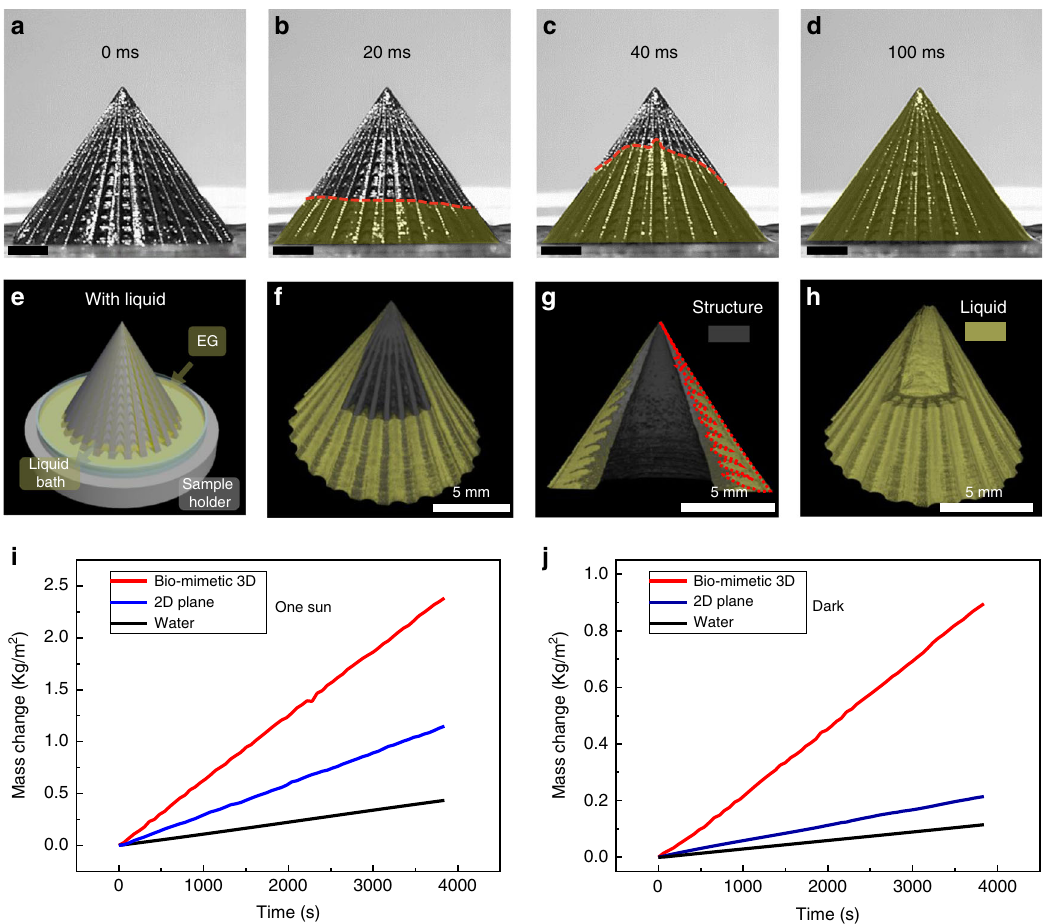
Fig. 2 Inhomogeneous water fi lm induced solar-driven water evaporation enhancement. a – d Time sequence of optical captures displaying the ultra-fast water upward spreading process on the biomimetic 3D evaporator surface. Scale bars are 2 mm. e – h 3D reconstruction of the equilibrium state of the biomimetic 3D evaporator in the wet state through Micro-CT from different viewing points. Panels ( e ), ( f ), and ( g ) are the scheme of the Micro-CT con fi guration, side view Micro-CT, and cross-sectional Micro-CT images of the reconstructed wet sample, respectively. Ethylene glycol (EG) with high boiling poit is utilized as the test liquid to reduce the in fl uence of the liquid evaporation during Micro-CT characterization process. The red dot line in ( g ) represents the contact line between liquid and the microcavity structure of the biomimetic 3D evaporator. h Micro-CT image of the solely reconstructed hierarchical water pathway with thickness gradient generated on the biomimetic 3D evaporator surface. i The mass change of the water on the biomimetic 3D evaporator under one sun illumination (1 kW m − 2 ), with pure water and 2D plane as controls. Red, blue, and black lines represent mass-change curves of the biomimetic 3D structure, the 2D plane, and pure water under one sun illumination, respectively. j The mass change of the water on the biomimetic 3D evaporator in darkness, with pure water and 2D plane as controls. Red, blue, and black lines represent mass-change curves of the biomimetic 3D evaporator, the 2D plane, and pure water in darkness,